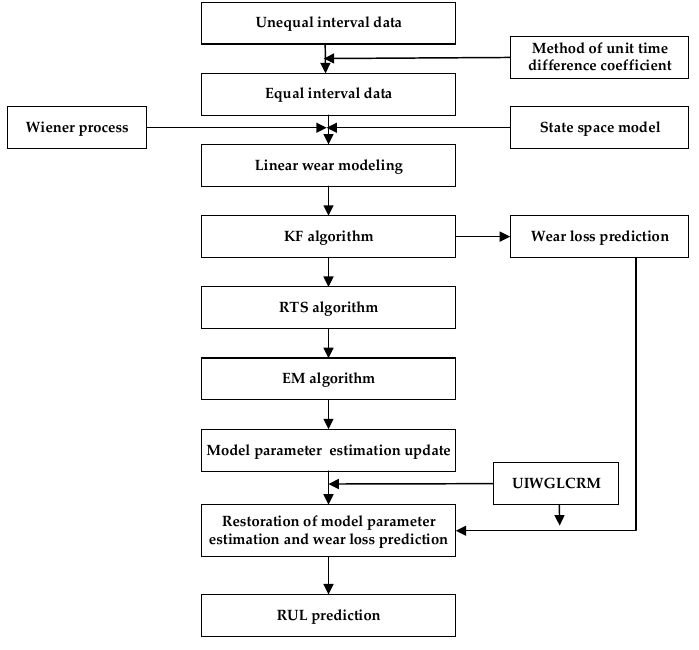
Figure 7. Flow chart of RUL prediction.